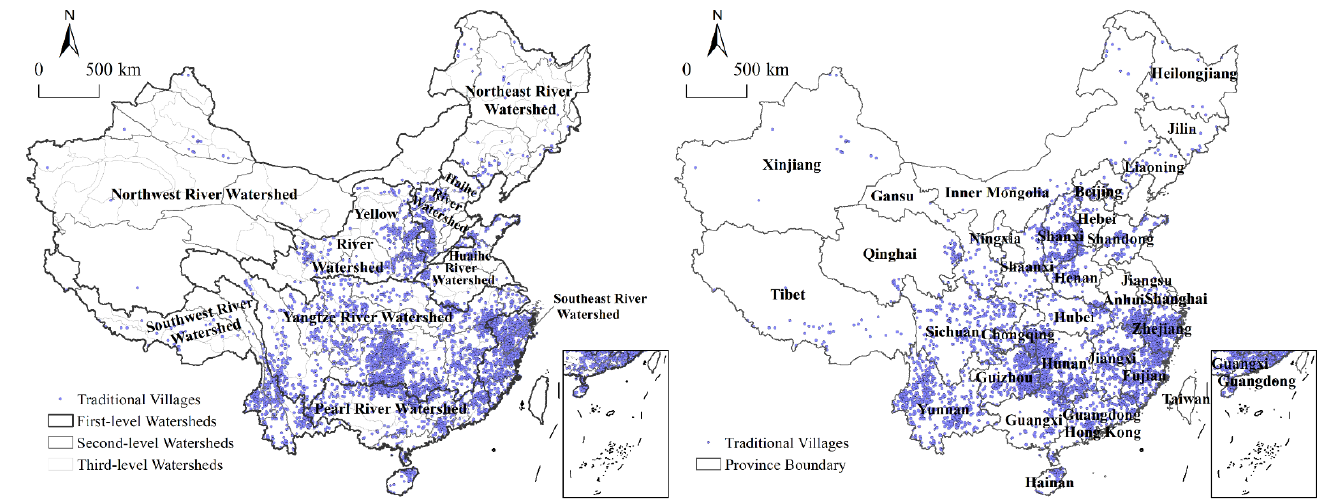
Figure 1. Distribution map of traditional villages in China.